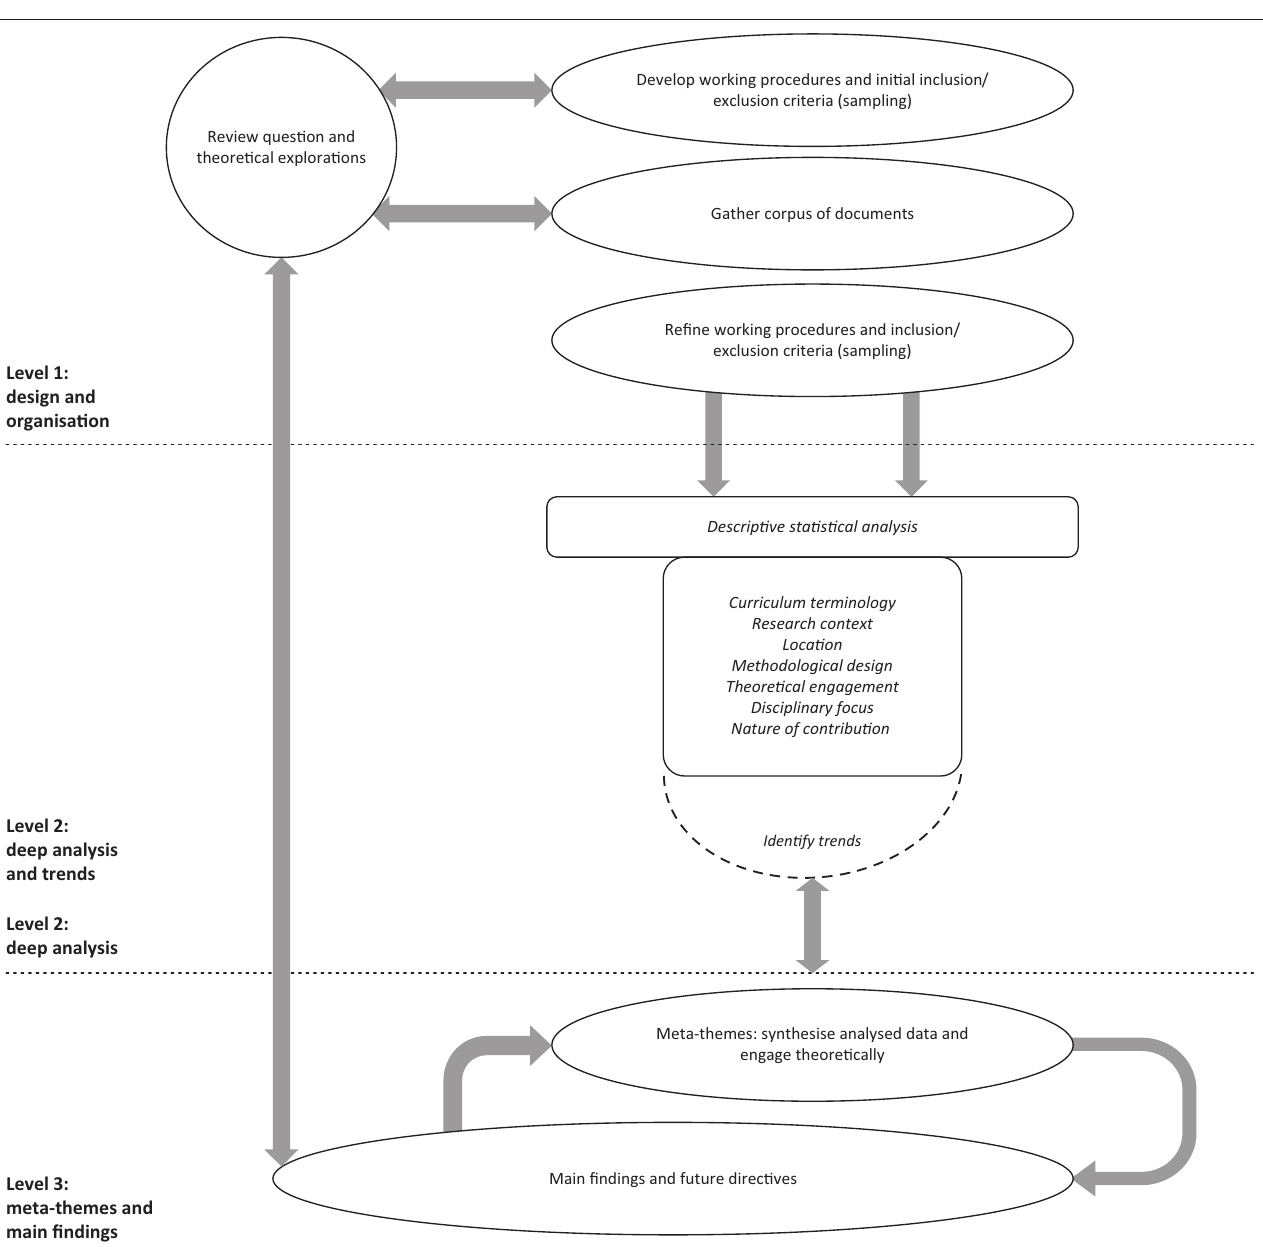
FIGURE 1: A schematic representation of the meta-study